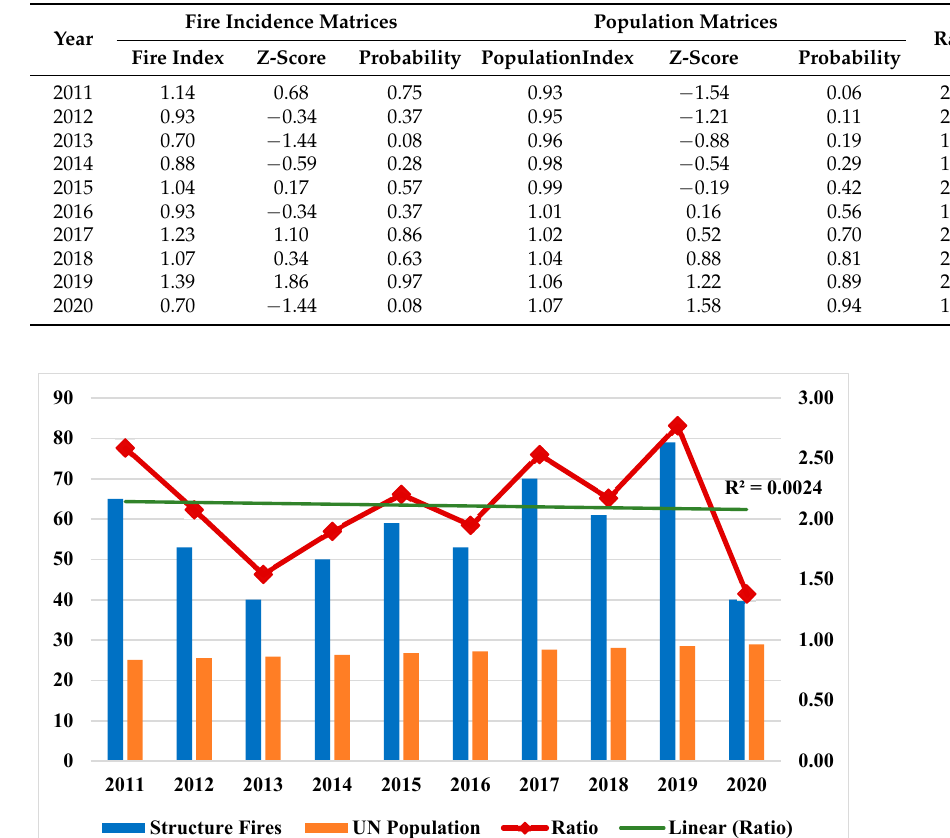
Figure 10. Yearly fire incidences, UN population, and ratio. Figure 11a depicts the waterfall chart of the evaluated z-score of the fire incidence pattern, as listed in Table 3, revealing the maximum increase in 2019 with a 1.86 z-score and decreasing in 2020 for a pandemic reason. Figure 11b depicts the evaluated propor- tion of the fire indexes reiterating the fact of maximum rise in 2019 with 39% above the mean value with the trend line of R square value of 0.00292 indicating a very slow but rising pattern. ( a ) ( b ) Figure 11. Temporal fire incidence pattern: ( a ) Z-score waterfall chart; ( b ) proportional fire index. Figure 12 depicts the temporal data of weekdays and hourly fire incidences. The weekdays dataset (as in Figure 12a) has the maximum fire frequencies on Thursday at 17% and a minimum on Monday at 12%, then the weekends. The hourly dataset (as in Figure 12b) has the maximum fire events during the hot afternoon hours from 12:00 to 17:00 with a maximum of 7% indicating the impact of climatic conditions and the human urban activities hours. The late hours from 19:00 to 21:00 correspond to dinner time, with the rise in fires indicating human activities. The Pearson’s correlation between the hourly fire frequencies has the coefficient value of 0.54, indicating a moderate correlation. The sensitivity analysis through autocor- relation test by Durbin–Watson (DW) statistics with the null hypothesis states that fire